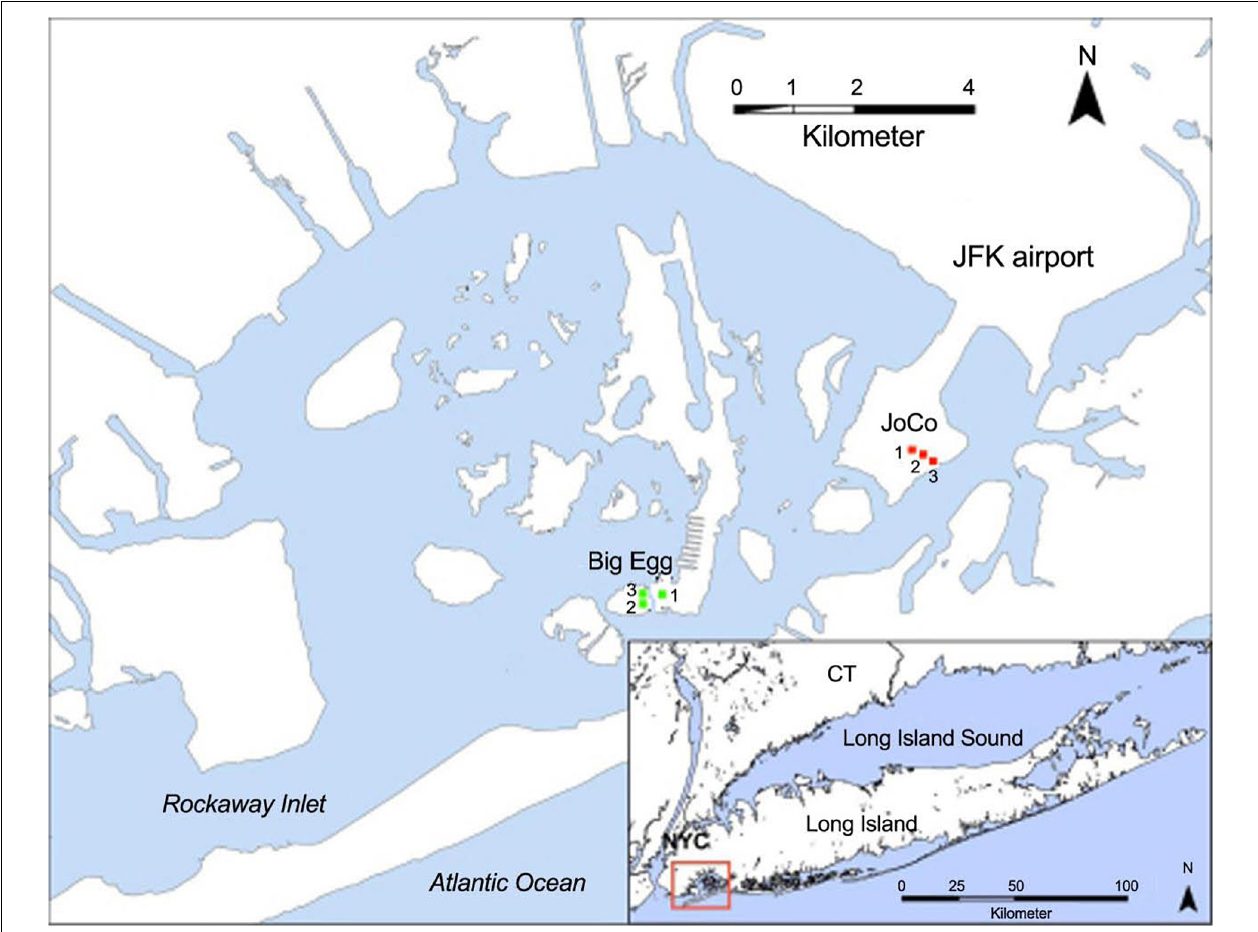
FIGURE 1 | Location of Jamaica Bay and the sampling sites at Big Egg (BE) and JoCo (JC). The GPS coordinates of sampling sites are BE1 (40.59604N, 73.82637W; restored in 2003), BE2 (40.59586N, 40.59586W), BE3 (40.59607N, 73.82812W), JC1 (40.61241N, 73.78779W), JC2 (40.61212N, 73.78724W), and JC3 (40.61173N, 73.78591W), respectively. Modified from Tamborski et al. (2017). Service Layer Credits: Source: Esri, DigitalGlobe, GeoEye, Earthstar Geographics, CNES/Airbus DS, USDA, USGS, AeroGRID, IGN, and the GIS User